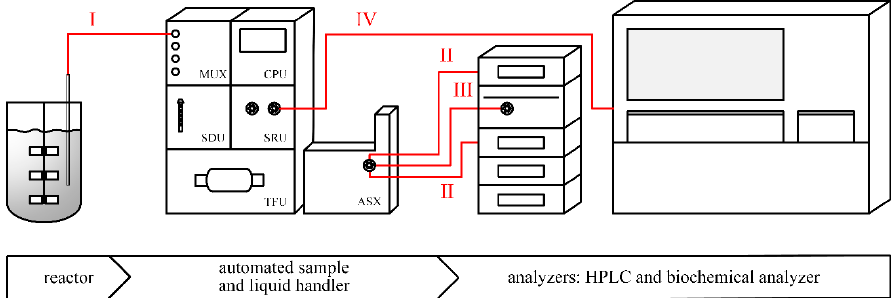
Figure 1. The set-up applied for the experiments consisted of a bioreactor, an automated